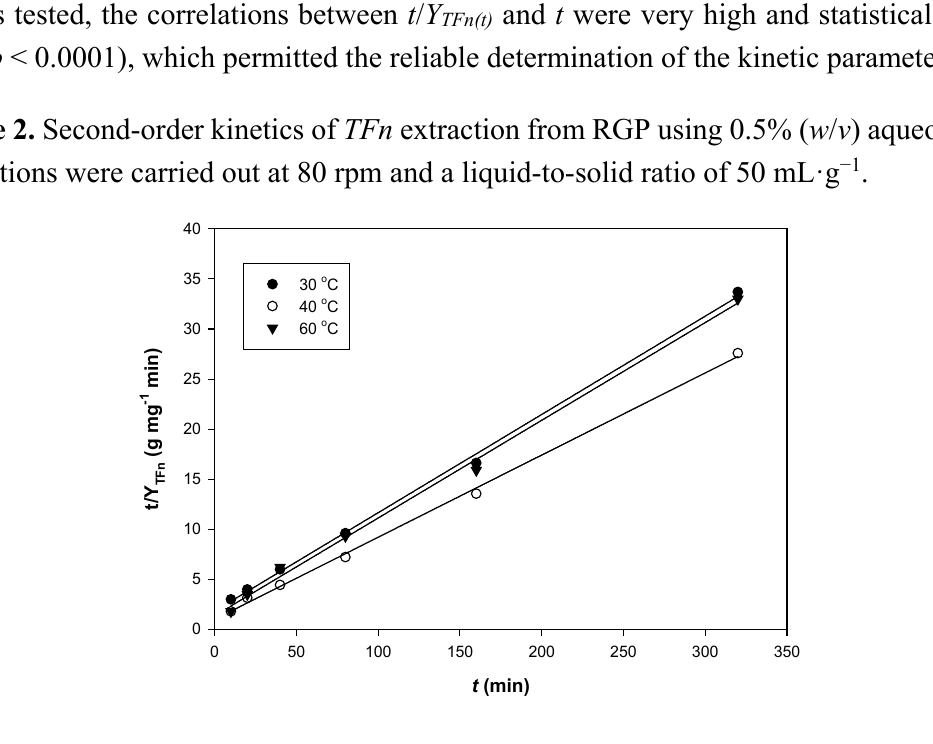
Table 1. Parameters of second-order kinetics, determined for the Y TFn using 0.5% ( w / v ) aqueous lactic acid, at the temperatures tested. dpw, dry pomace weight; RtE, rutin equivalents. Kinetic T (°C)